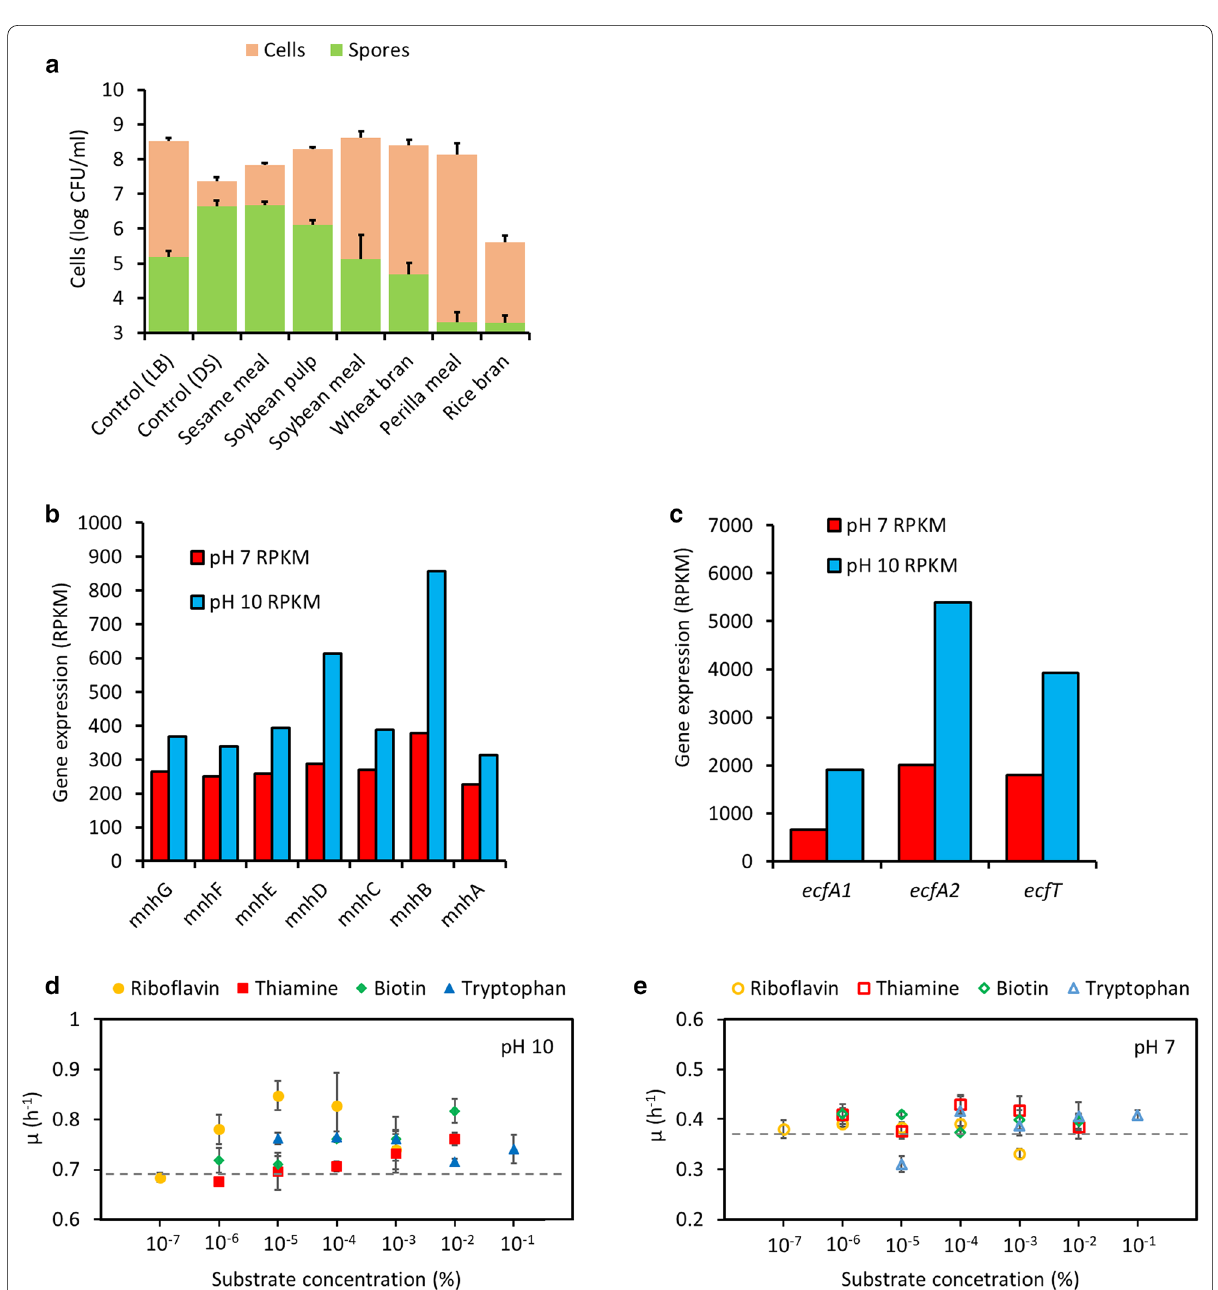
Fig. 1 Selection of agricultural by-product to make an economical medium for the growth and sporulation of AK13. a Selection of most effective agricultural by-product for AK13 spore formation. b Comparison of gene expression in Mrp antiporter operon at pH 7 and 10. c Expression of genes related to ECF transporter in pH 7 and 10 growth conditions. d , e Changes in the growth rate of AK13 following supplementation with four ECF transporter substrates in pH 7 and 10 LB media. The dotted lines indicate the growth rates of AK13 without